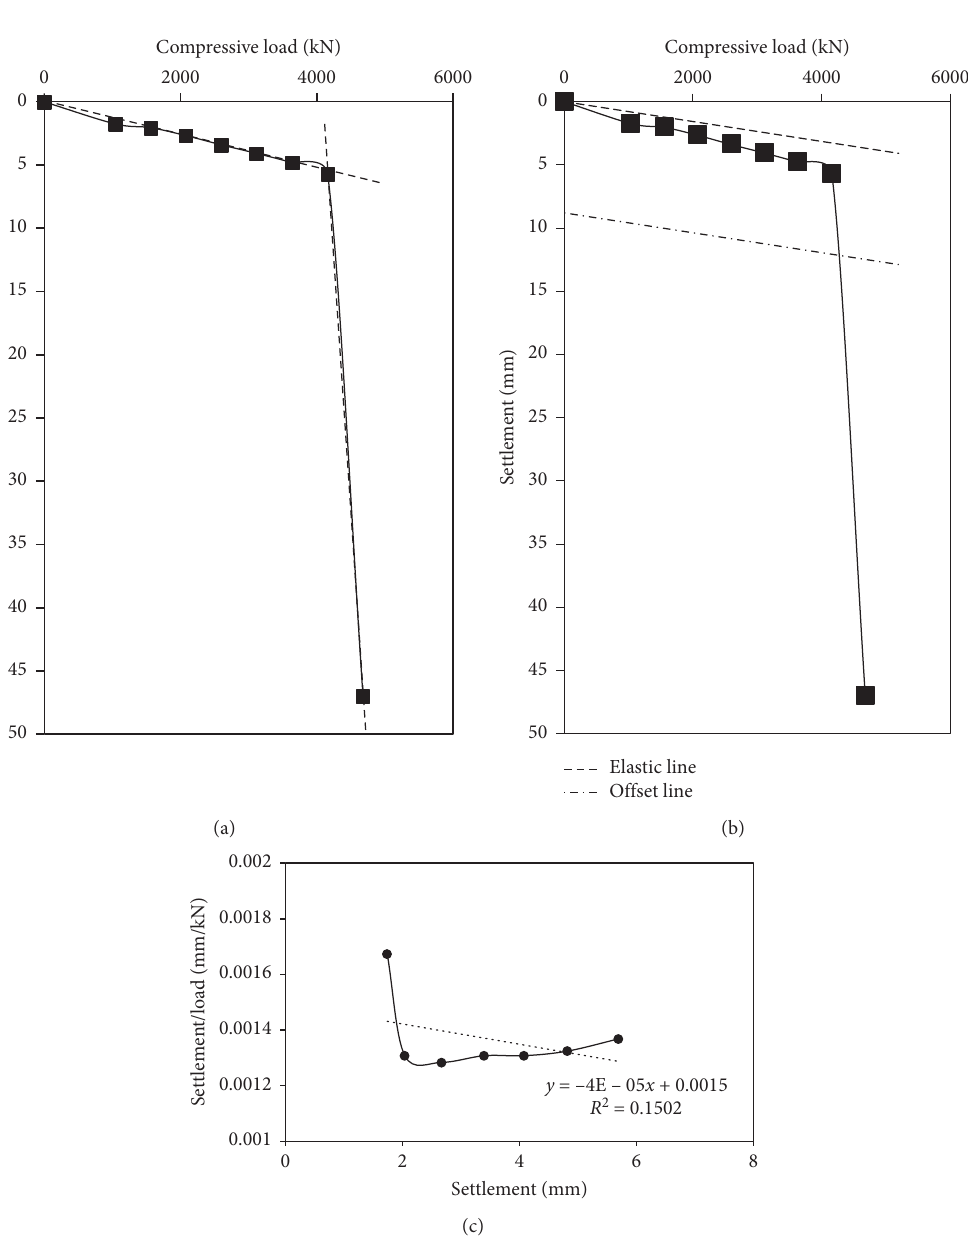
Figure 20: Interpretations of (a) the double tangent method; (b) Davisson’s offset method; (c) Chin’s method.